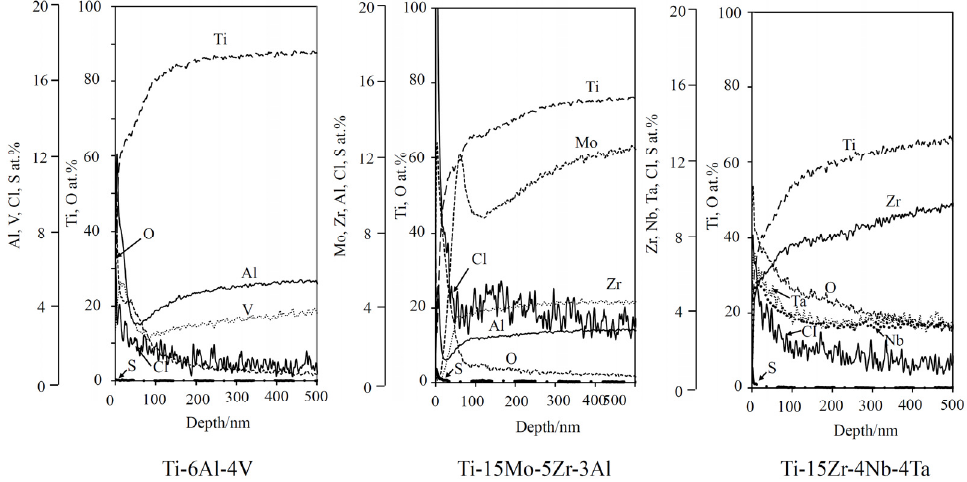
Figure 3. Glow discharge optical emission spectroscopy (GD-OES) depth profile of the surface of Ti alloys subjected to MA-heat treatment.